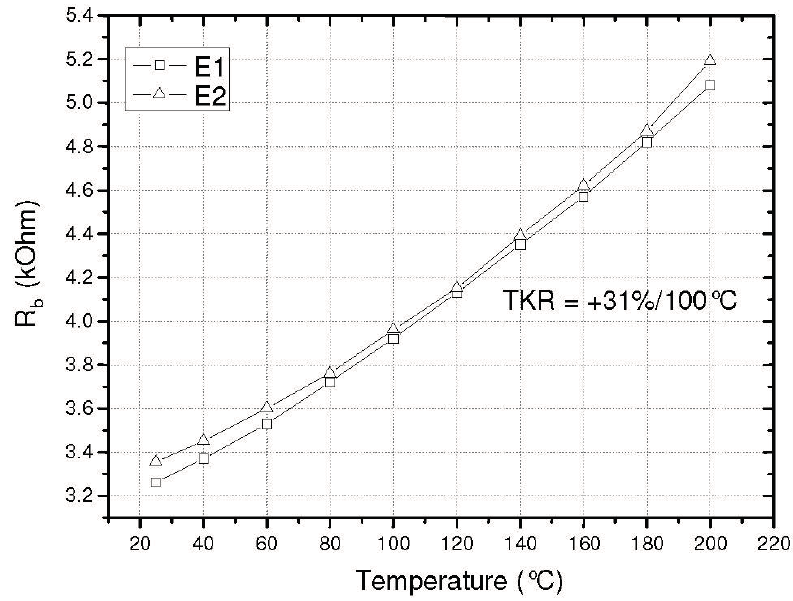
Figure 12. TCR of the SOI sensor chip for temperature up to 200 °C